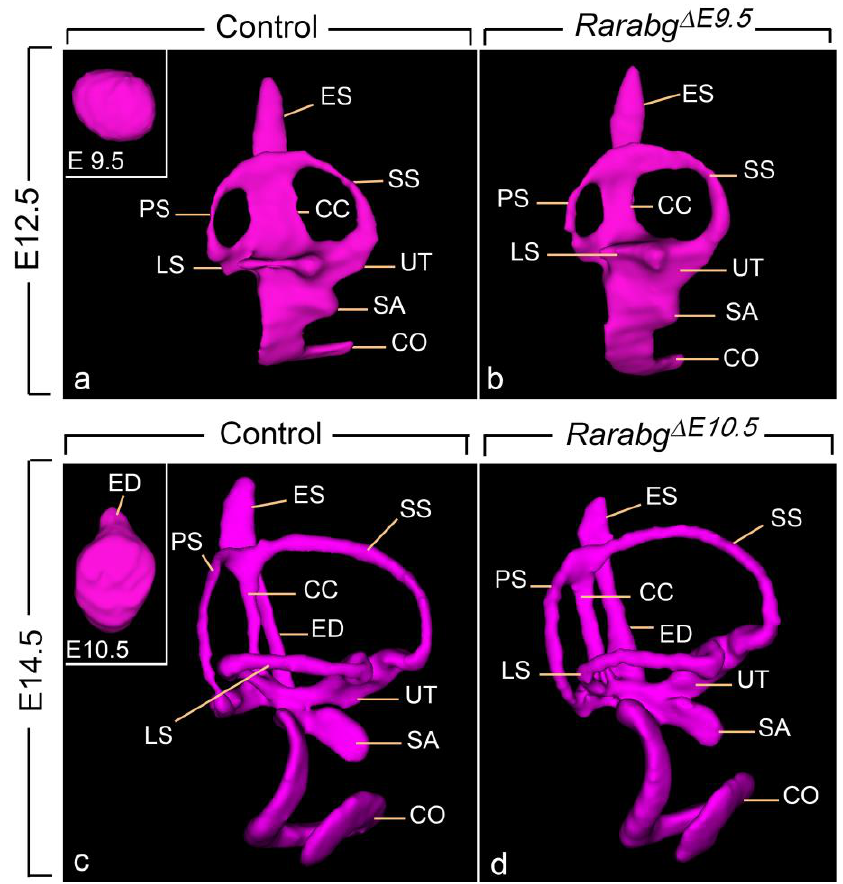
Figure 8. Lateral views of 3D-reconstructions of the right membranous labyrinth in control embryos ( a,c ), in a Rarabg ΔE9.5 mutant ( b ) and in a Rarabg Δ10.5 mutant ( d ) at E12.5 and E14.5, as indicated. The insets in ( a , c ) represent lateral views of normal otocysts at E9.5 and E10.5, respectively. CC, common crus; CO, cochlea; ED, endolymphatic duct; ES, endolymphatic sac; LS, lateral semicircular canal; PS, posterior semicircular canal; SA, saccule; SS, superior semicircular canal; UT, utricle. Same magnification in ( a – d ).